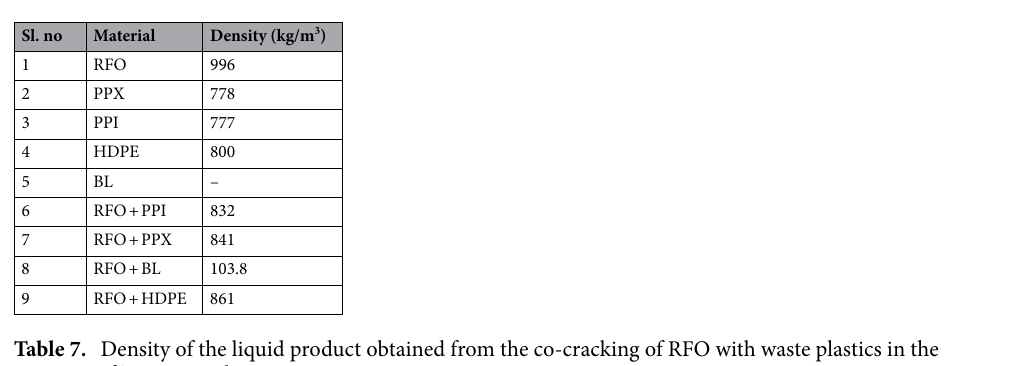
Table 7. Density of the liquid product obtained from the co-cracking of RFO with waste plastics in the presence of ZSM-5 catalyst.